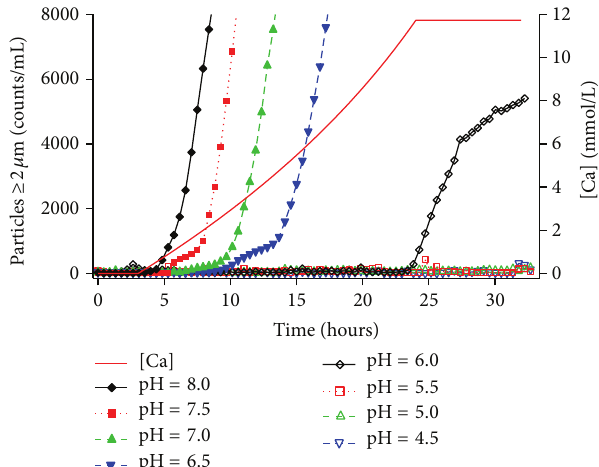
Figure 5: The pH dependence ranging from 4.5 to 8.0 of calcium phosphateparticleformation ≥ 2micronsforanutritionaladmixture storedat37 ∘ Cismonitoredwithsimultaneouscalciumadditionover a 30-hour period. The concentration of calcium started at 0mmol/L initially and reached ∼ 12mmol/L after 24 hours of continuous addition while the concentration of phosphates was ∼ 24mmol/L throughout the experiment. For pH ≥ 6, as the pH increases, the calcium addition time is shorter before the appearance of increased particle counts/mL. There are also observed inflection points in the rates of increase in particle concentrations for the admixtures where calcium phosphate precipitation was